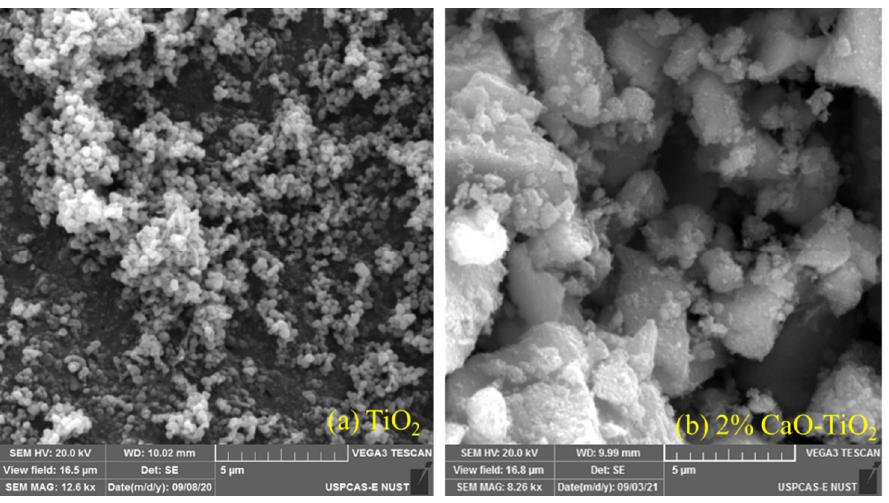
Figure 5. SEM micrographs of ( a ) TiO 2 ( b ) 2% CaO-TiO 2.